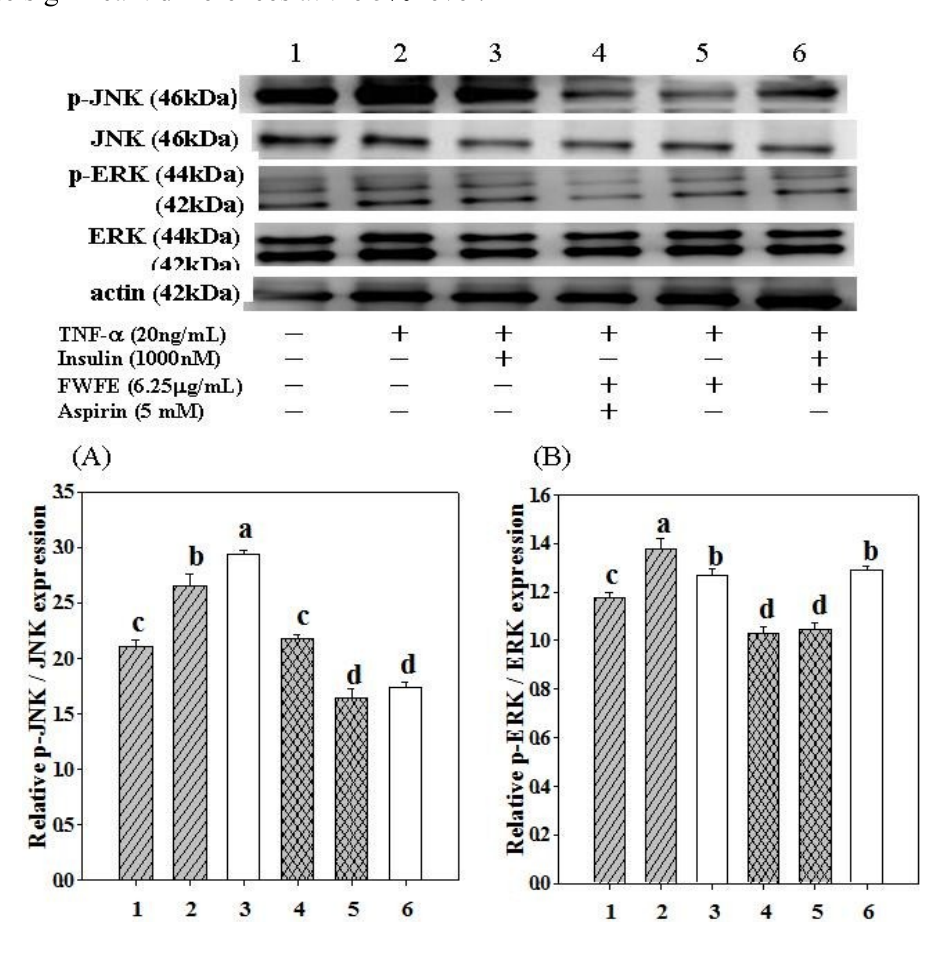
Figure 4. Effect of FWFE on phosphorylated JNK and ERK expression in TNF- α -induced insulin resistant FL83B cells. FL83B cells were incubated in serum-free F12K medium, with or without added TNF- α (20 ng/mL), incubated at 37 °C for 5 h, transferred to another serum-free F12K medium with or without insulin (1000 nM), FWFE (6.25 μ g/mL) Aspirin (5 mM) , and then incubated for an additional 30 min. The relative expressions of JNK and ERK in each treatment group were calculated using actin as the standard. Letters a~d indicate significant differences at the 5%